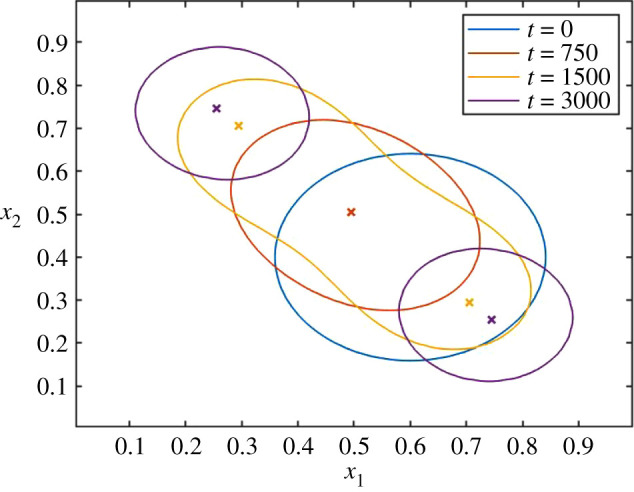
Illustration of a speciation event as calculated by the PLM, and induced by a bifurcation in the maximum for the trait-dependent growth rate r(x, t) at t = 1000 as explained in the text. The figures show the solution of equation (2.1), plotted as the curves where abundance n(x, t) = 10−4. Initially (blue and red curve), only a single species can be defined, while eventually (purple curve), two distinct species can be defined. At the time of the yellow curve, the transition is in progress. The maximum of r(x, t) is marked by an ‘x’ for each t, but the maximum for t = 0 (blue) is invisible because it coincides with that for t = 750 (red).